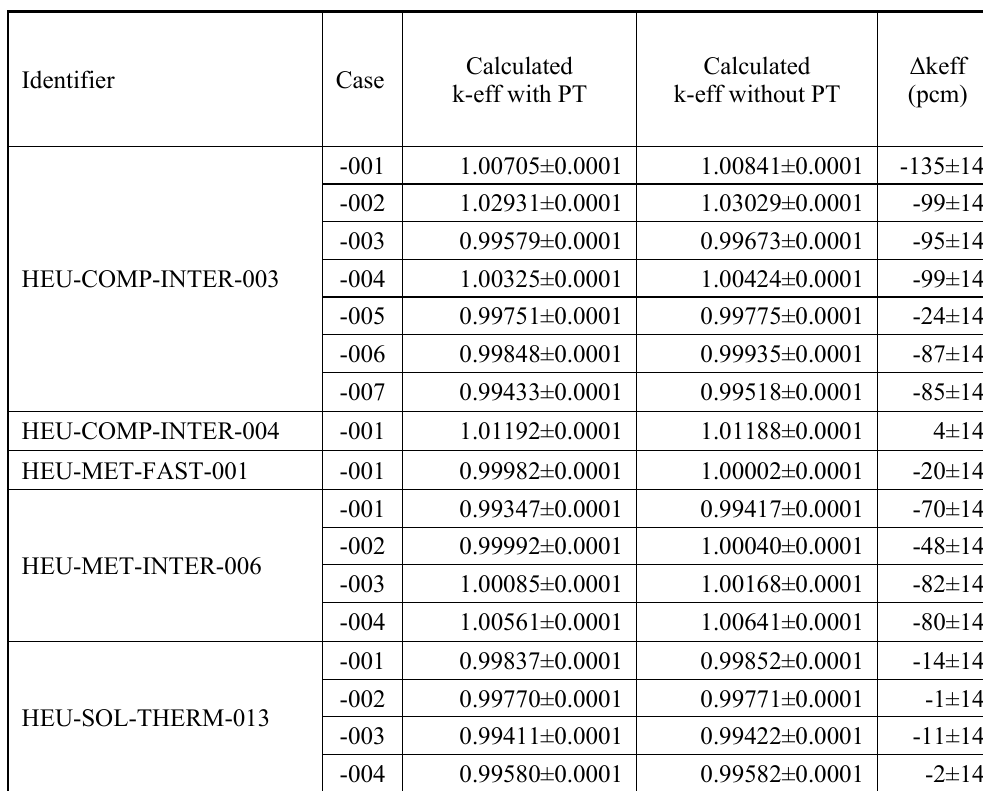
Table II. Effect of PT on